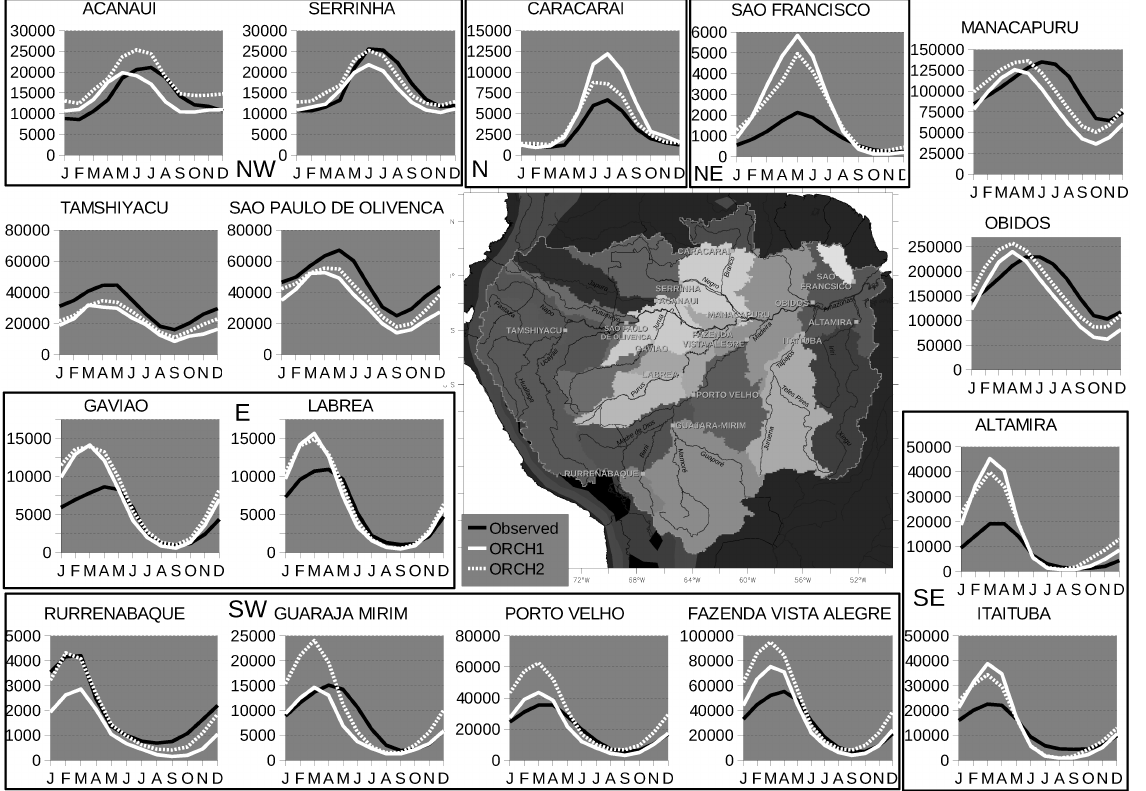
Fig. 11. Mean seasonal discharges (m 3 s − 1 ) over the sub-basins for simulations ORCH1 and ORCH2 compared to observations, over the mean period 1980–2000. The stations are organized according their locations – North (N), North-East (NE), East (E), South-East (SE), South-West (SW), West (W) and North-West (NW).